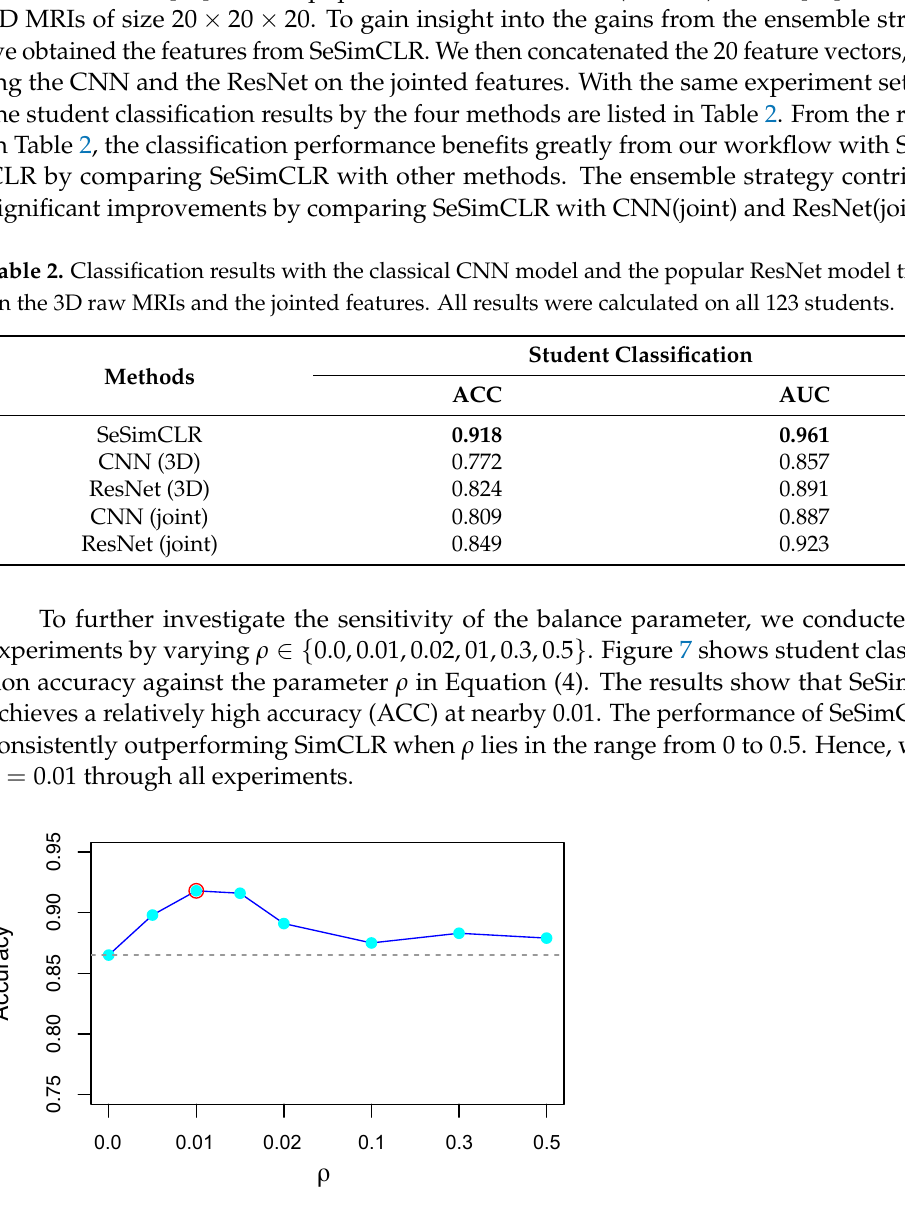
Figure 7. Accuracy against ρ . The classification results in terms of accuracy for various ρ